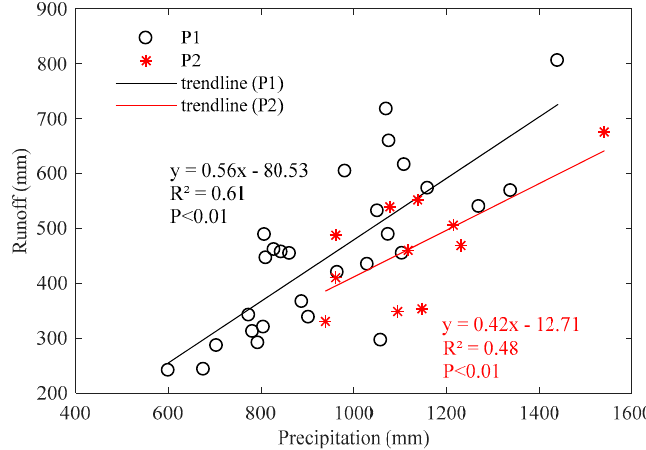
Figure 8. Correlation relationship between runoff and precipitation in P1 (pre-mining period) and P2 (post-mining period).